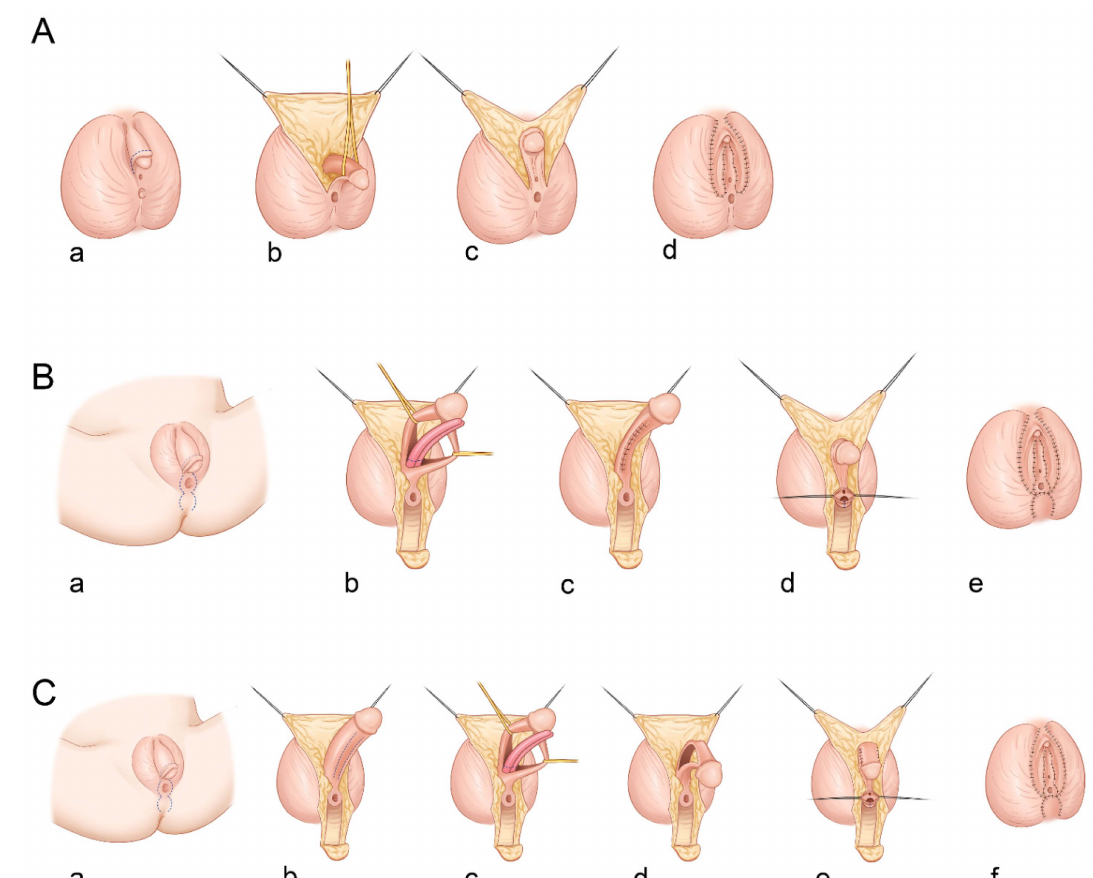
Figure 1. Surgical techniques of clitoroplasty: ( A ) recession clitoroplasty without reduction of corporal tissues ( a – d ); ( B ) reduction clitoroplasty method in which the incision line is depicted in blue dot ( a ), the corporal bodies are excised with preservation of the glans clitoris and neurovascular bundles ( b , c ), and the posterior vaginal wall is reconstructed with the perineal skin flap ( d , e ); ( C ) girth-reduction clitoroplasty in which the glans and corporal bodies are divided in the coronal plane and the ventral portions of the shaft, and glans are excised ( b , c ), the dorsal neurovascular bundles are preserved ( d ), and the remaining portion of the clitoris is bent in a hairpin configuration by suturing the exposed surfaces of the corporal bodies ( e , f